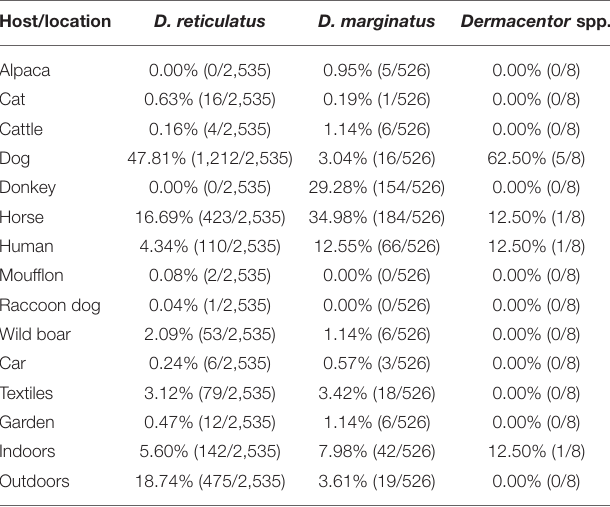
TABLE 2 | Host association or location of collection for the subset of Dermacentor ticks for which this information was available.